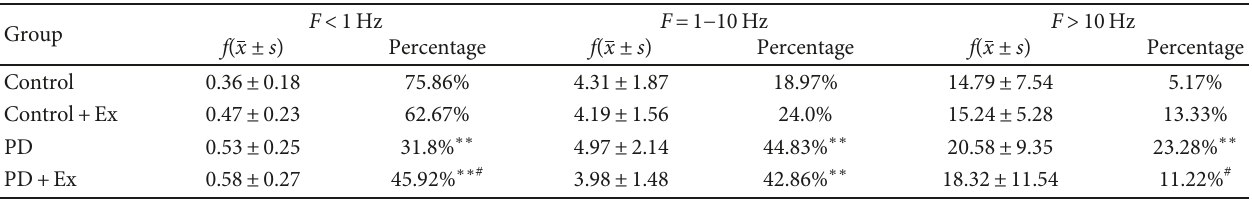
Figure 7: E ff ect of treadmill exercise on spontaneous fi ring patterns and average fi ring rate of striatal neurons in the rat model of Parkinson ’ s disease. (a) Analysis of spontaneous fi ring patterns in striatal neurons. (b) Change in the average fi ring frequency in striatal neurons. Compared to the control groups, ∗ P < 0 05 and ∗∗ P < 0 01 . Compare to the PD groups, # P < 0 05 and ## P < 0 01 . Control: control group; Table 2: Distribution of spontaneous fi ring rate of striatal neurons in